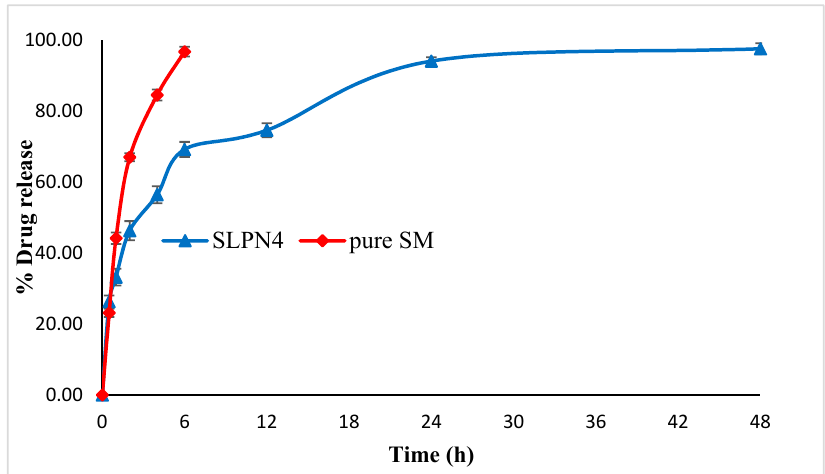
Figure 6. Comparative in vitro release profile of pure SM and optimized LPHNPs (SLPN4).